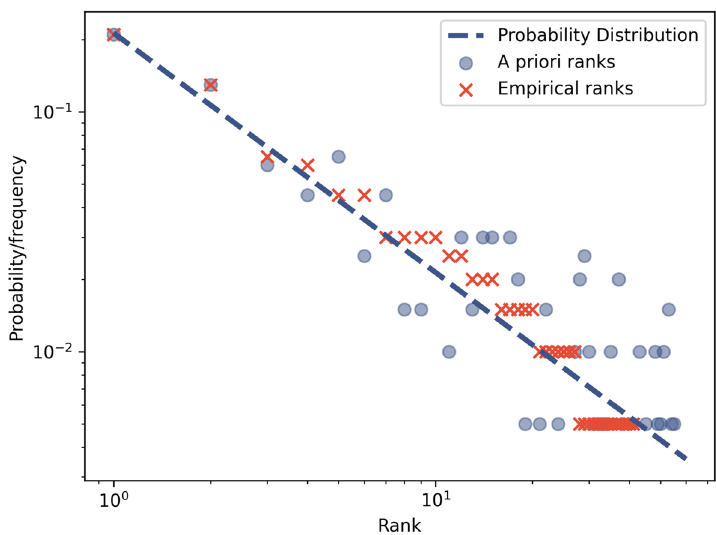
Figure 2. Difference between distributions with probability and empirical ranks. Data was generated from an underlying power law probability distribution with exponent (cid:31) = 1 , number of possible events W = 60 and N = 200 samples. The dotted blue line shows the probability distribution. The blue circles show the sampled event frequencies with a priori known probability ranks. The red crosses show the empirical rank-frequency distribution from the same data. There is a significant difference between the two distributions. The current estimators are designed to fit data with a priori known ranks, not empirical